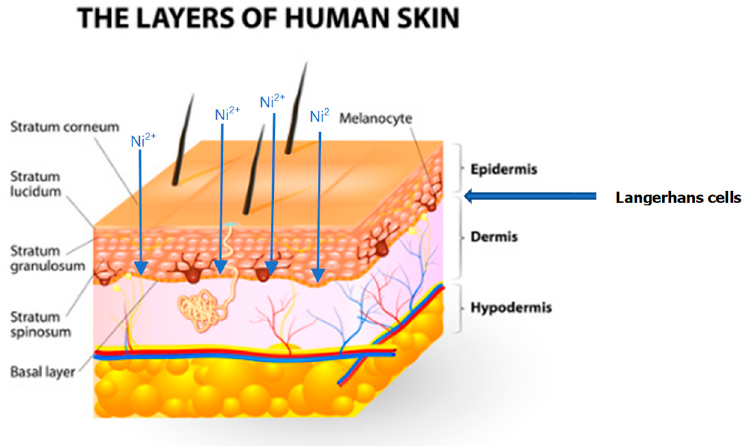
Figure 1. Nickel ions from exposure to solubilized nickel compounds or released from corrosion of nickel metal or alloys must cross the skin barrier and reach the basal layer of the epidermis to cause an allergic reaction. Modified with permission from original image: Designua/Shutterstock.com.